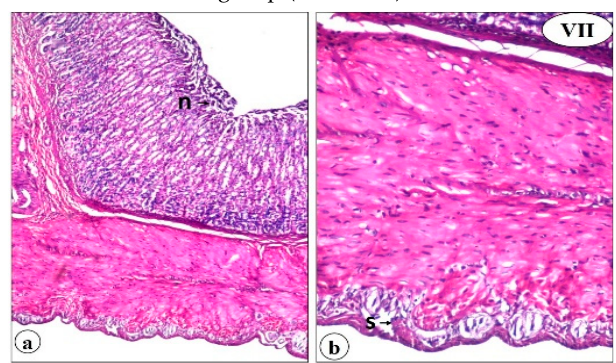
Figure 3. V-a. Showing focal necrosis (n) and Figure 3. VI-a. Showing focal necrosis (n) and desqua- desquamation of the mucosal lining epithe- mation of the mucosa, VI-b: showing the VIa magnifi- lium, V-b: showing normal intact submucosa cation (×40) and oedema of serosal layer (s) in SFP- and muscularis, also oedema and thickening in treated group (H&E × 16). serosa (s) was remarked (o) in KP-treated group (H&E × 16).